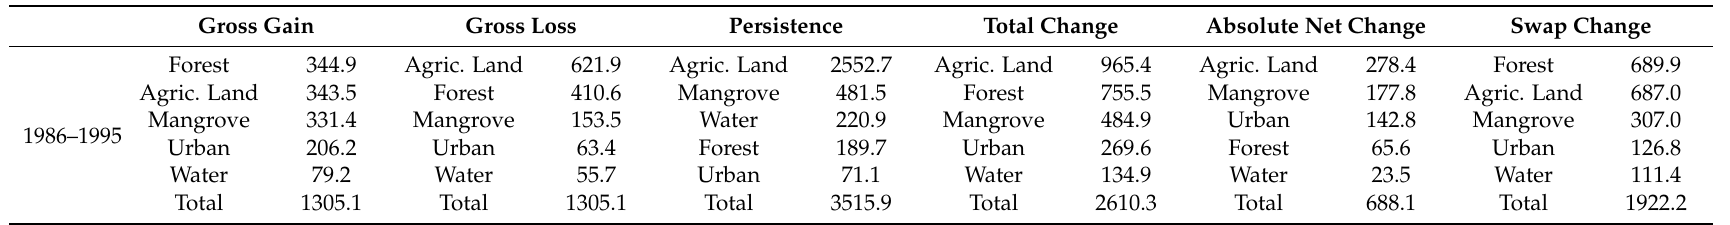
Table 9. Ranking of gross gains, gross losses, persistence, total change, and swap change of LULC categories between 1986–1995. Gross Gain